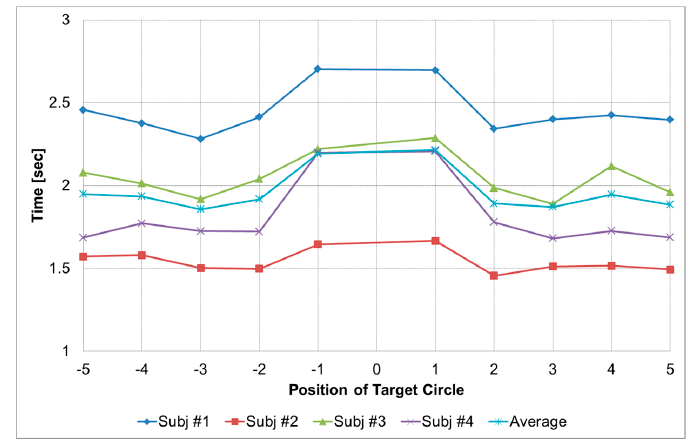
Figure 14. Plot of required time to complete the drag-and-drop operation.